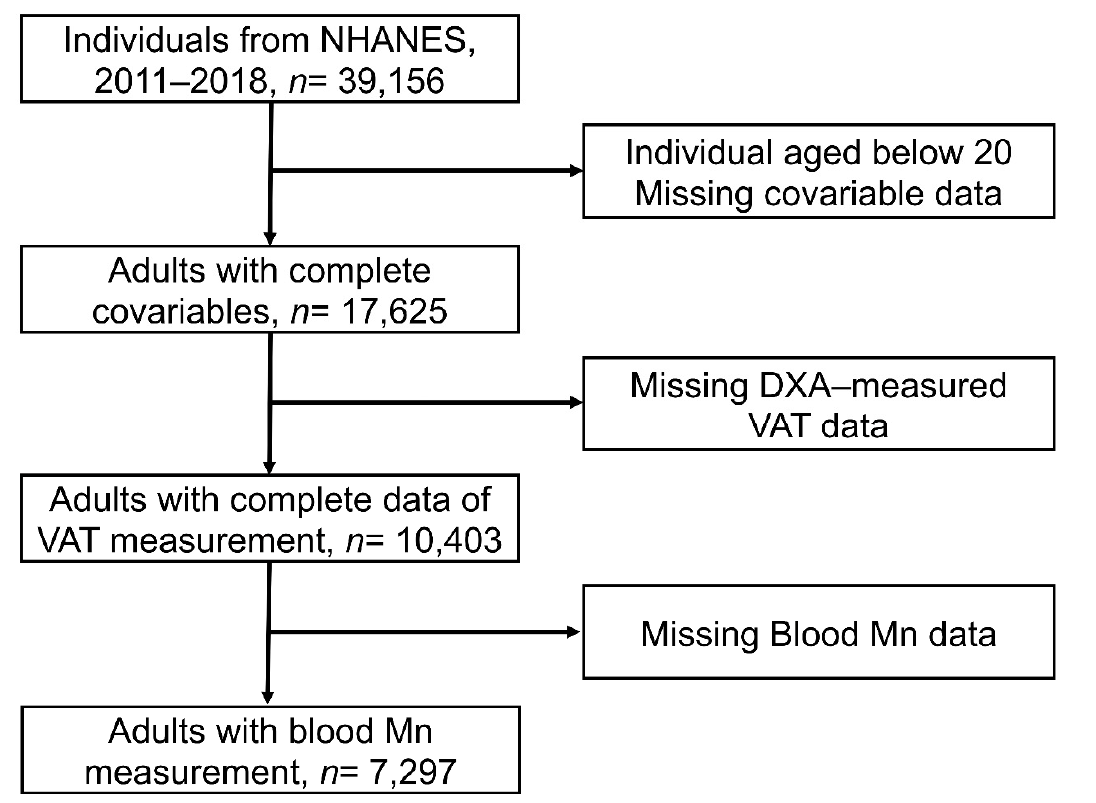
Figure 1. Flow chart of the study.